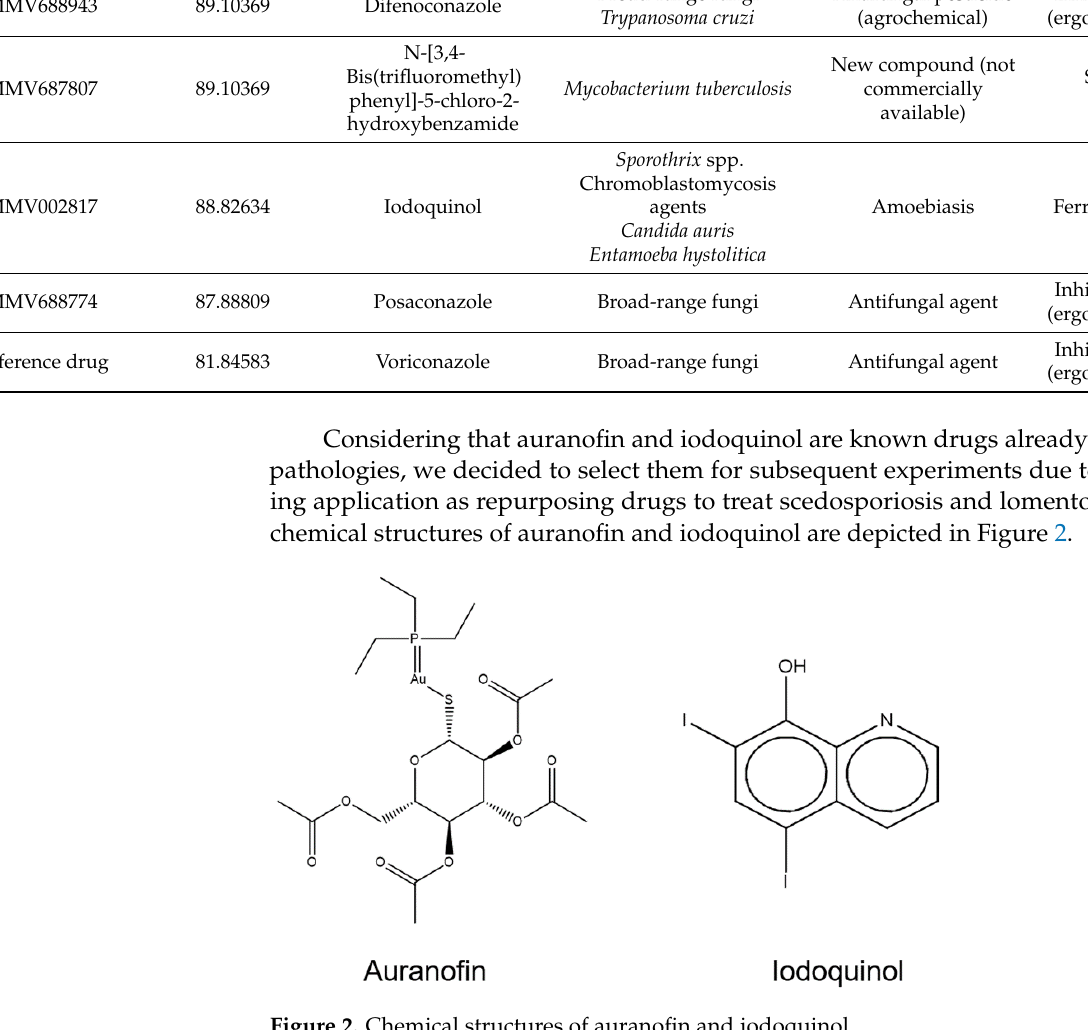
Table 2. Minimum inhibitory concentration of auranofin, iodoquinol and voriconazole against several Scedosporium and Lomentospora species.